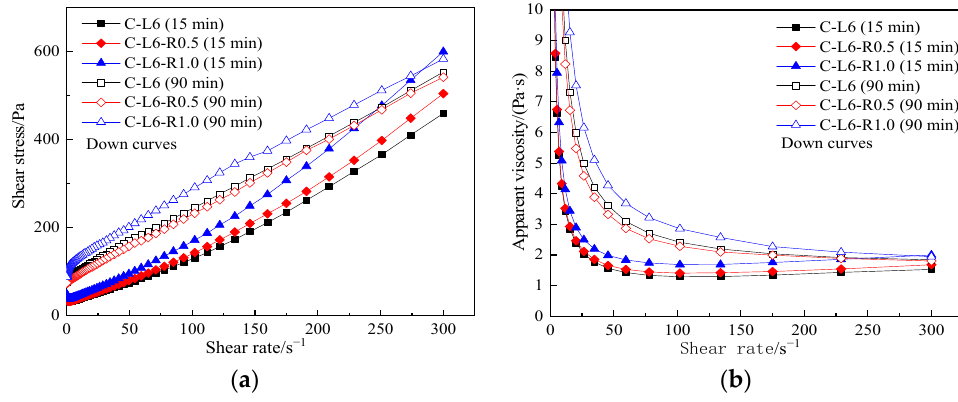
Figure 13. Rheological curves of C-L6-RPP pastes. ( a ) shear stress vs. shear rate, ( b )apparent viscosity vs. shear rate.